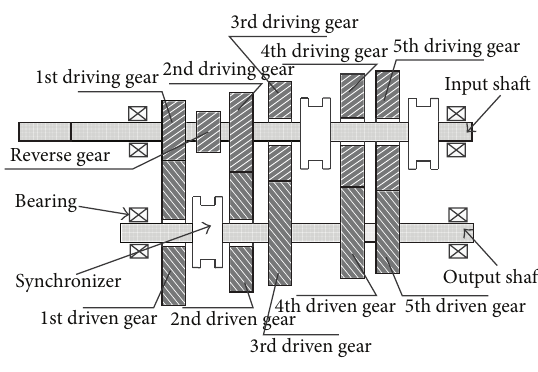
Figure 8: Mechanical structure of 5-speed MT.